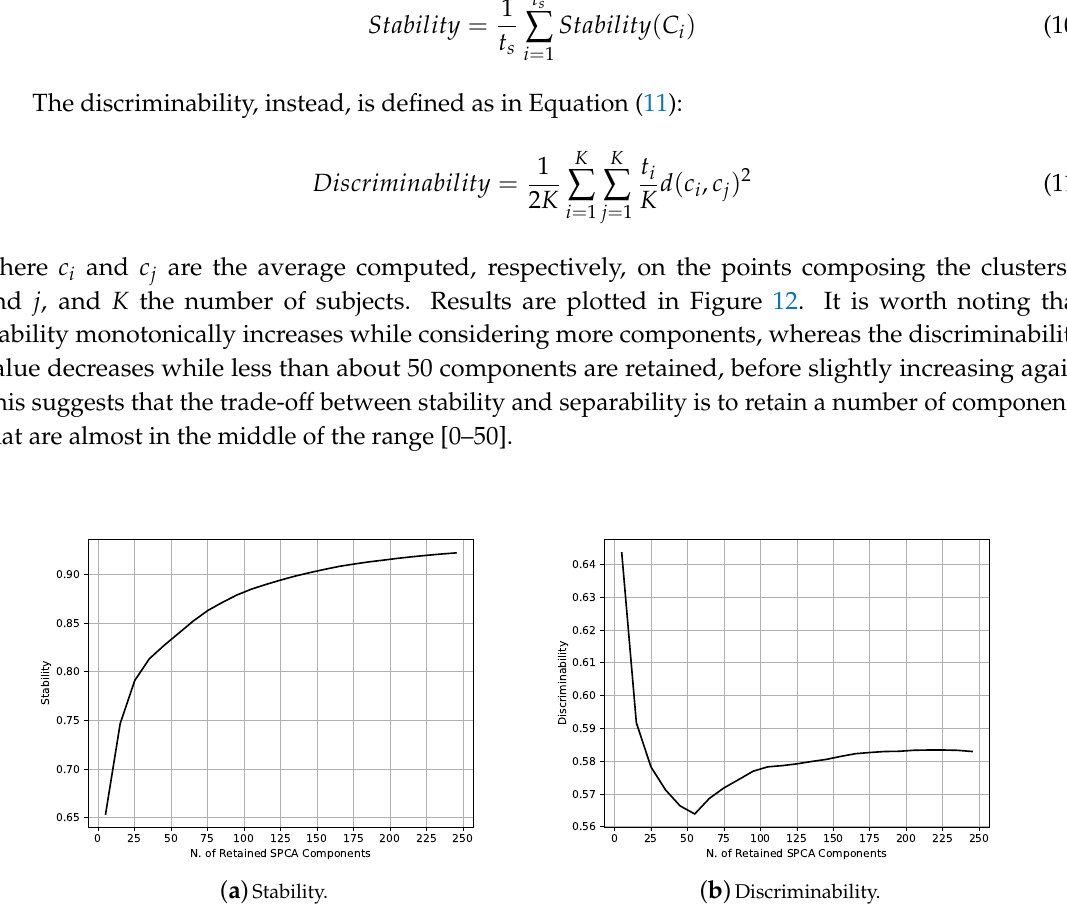
Figure 12. Stability ( a ) and discriminability ( b ) plots while varying the number of retained SPCA